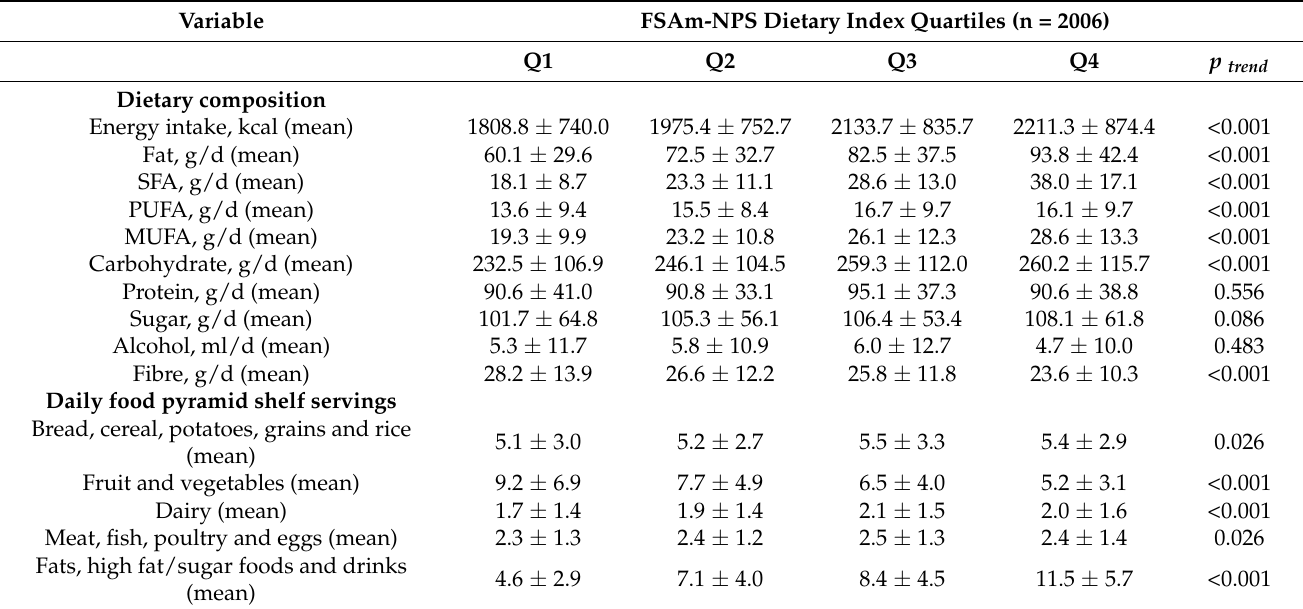
Table 2. Nutritional intake of the study population according to FSAm-NPS dietary index